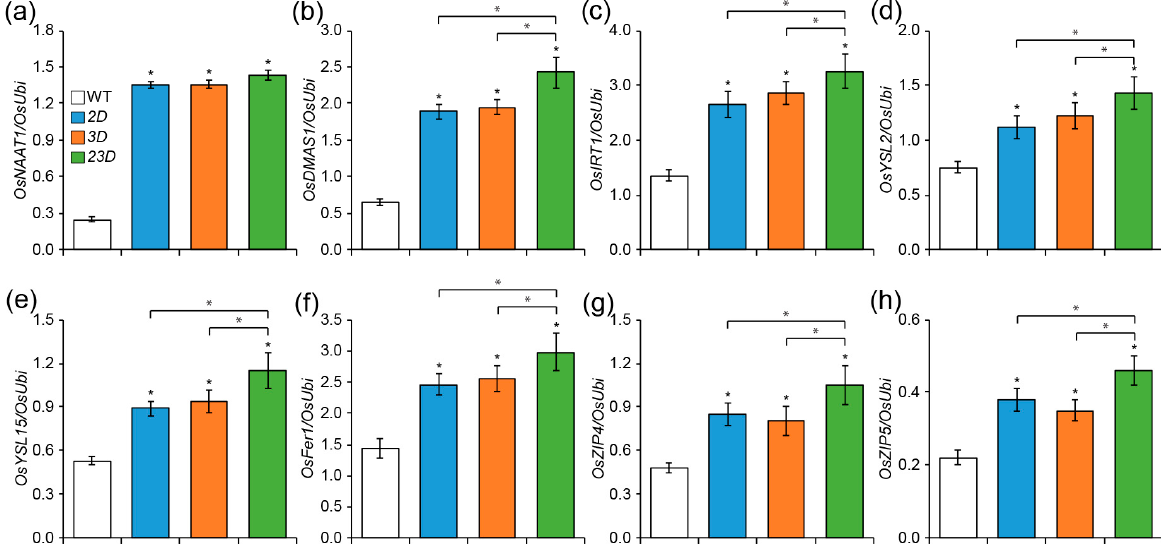
Figure 2. Quantitative RT-PCR analysis of Fe and Zn homeostasis-related genes at the seedling roots. Plants were grown under the control Yoshida solution for 10 days. Levels of OsNAAT1 ( a ), OsDMAS1 ( b ), OsIRT1 ( c ), OsYSL2 ( d ), OsYSL15 ( e ), OsFer1 ( f ), OsZIP4 ( g ), and OsZIP5 ( h ) in the roots of WT and activation-tagged mutants. Significant differences among WT and mutant plants are indicated with an asterisk (* p < 0.05 by Student’s t -test).